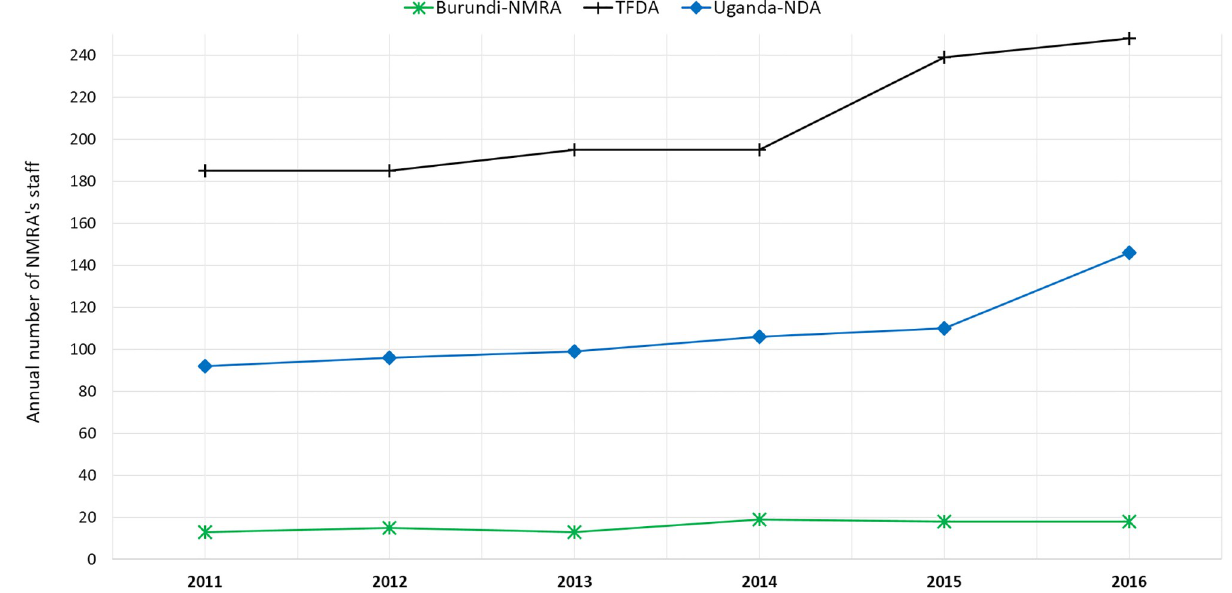
Fig 5. Annual trend in the number of staff per national medicines regulatory